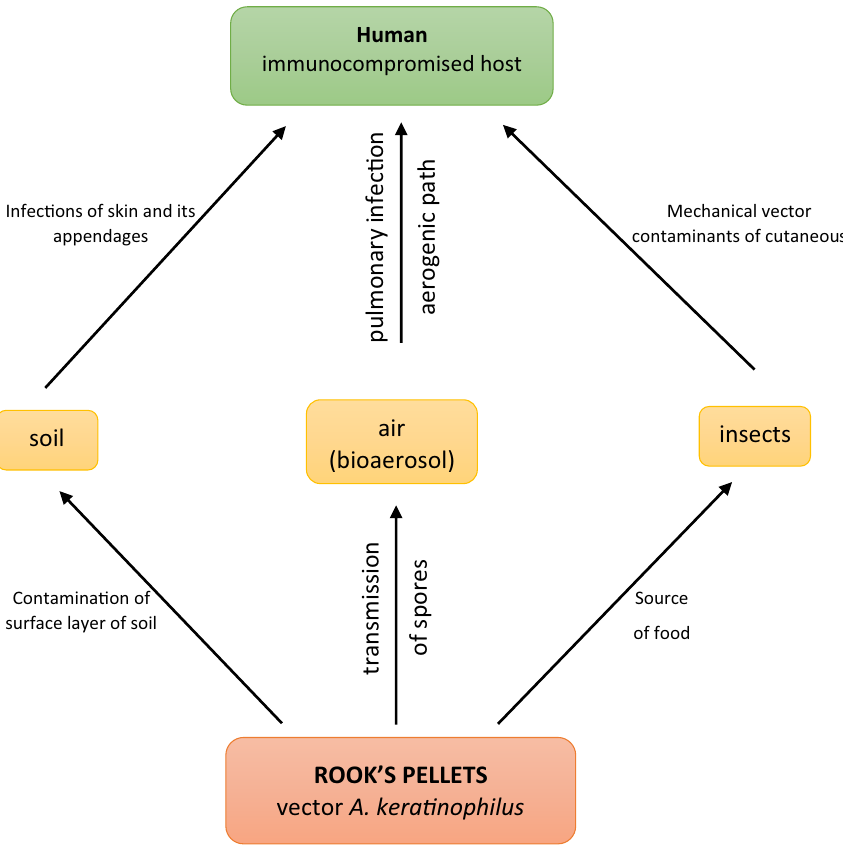
Figure 3. Possible pathways of dispersal and infections with opportunistic strains of Aphanoascus keratinophilus with the participation of rook